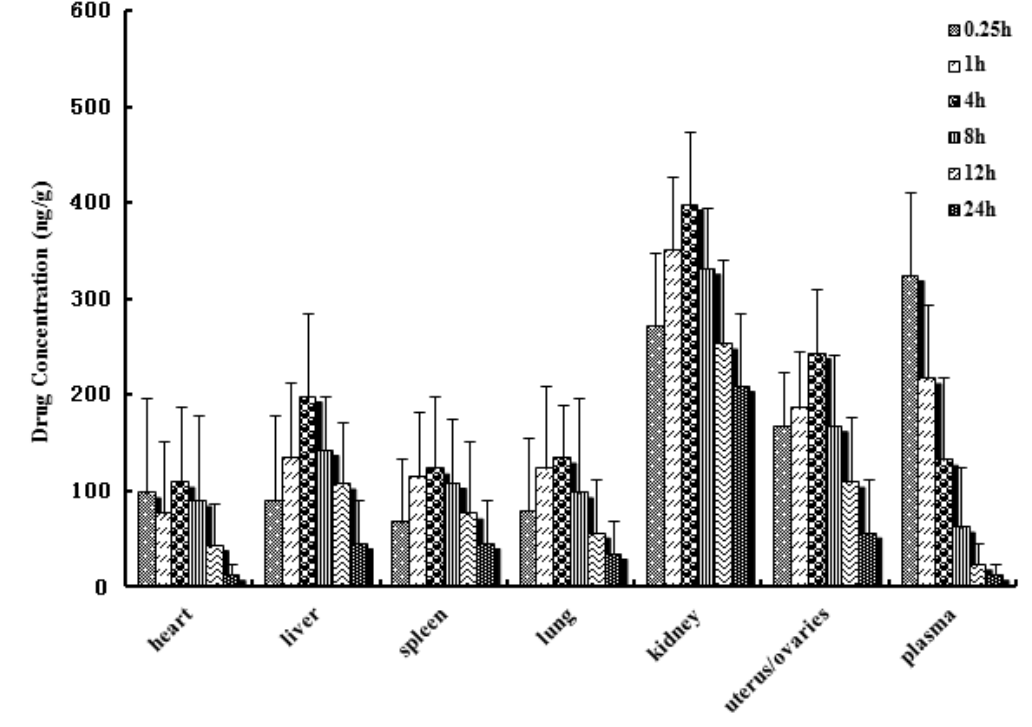
Figure 5. Distribution in tissue in mice after following i.v. administration of a single 5 mg/kg dose of DTX injection tissues (ng/g) and plasma (ng/mL), (Each point represents the mean ± SD of 5 mice).